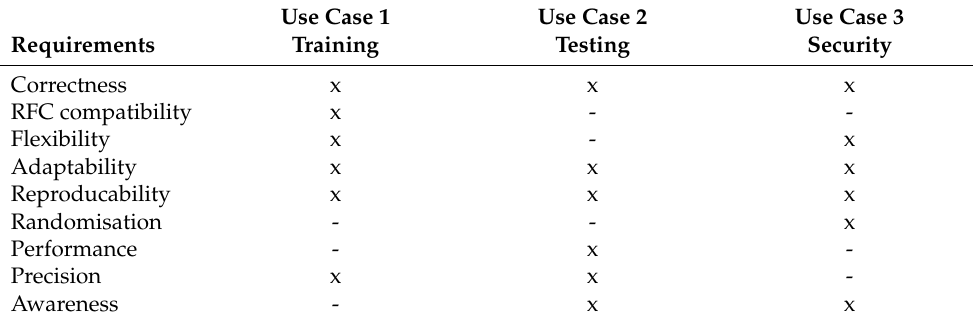
Table 1. Use case